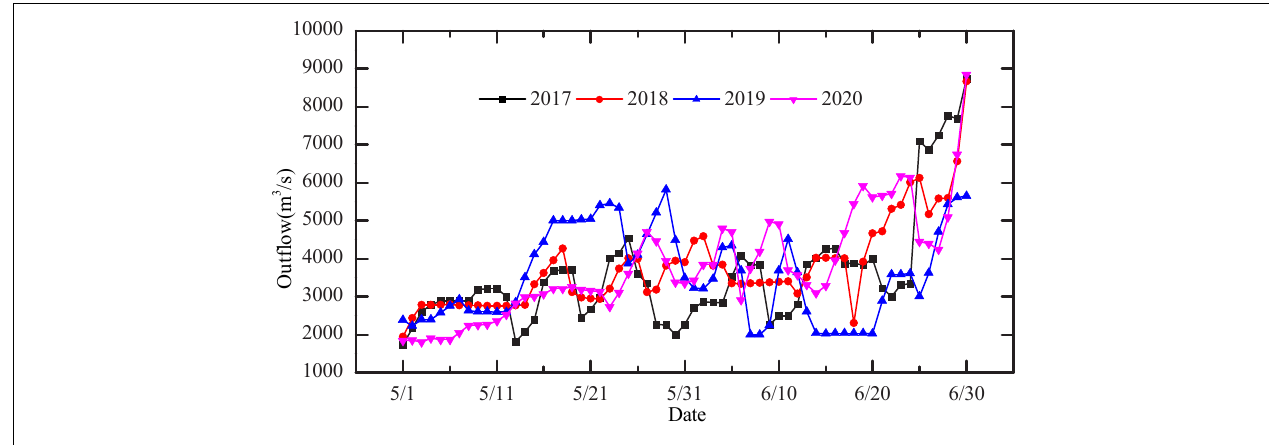
FIGURE 9 | Daily outflow from the Xiangjiaba Reservoir during ecological